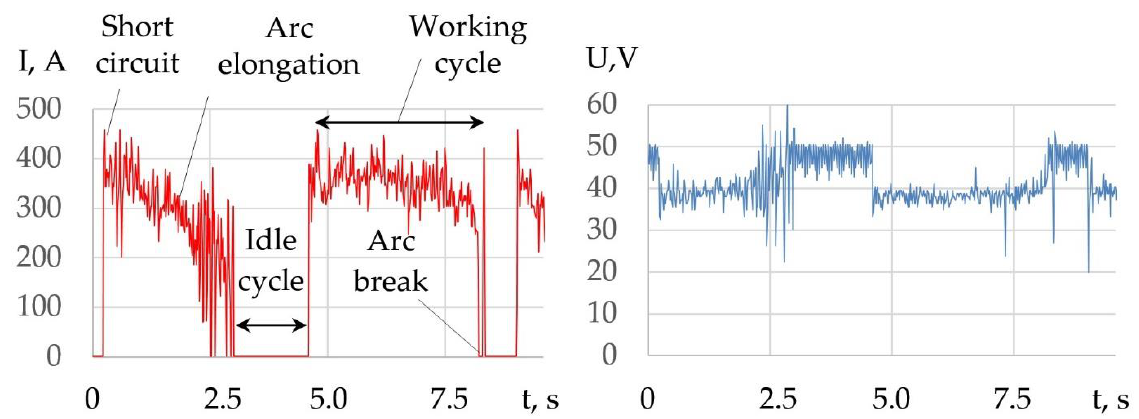
Figure 3. Typical oscillogram of current and voltage during underwater cutting with a 2 mm diameter PPR-APL1 flux-cored wire.